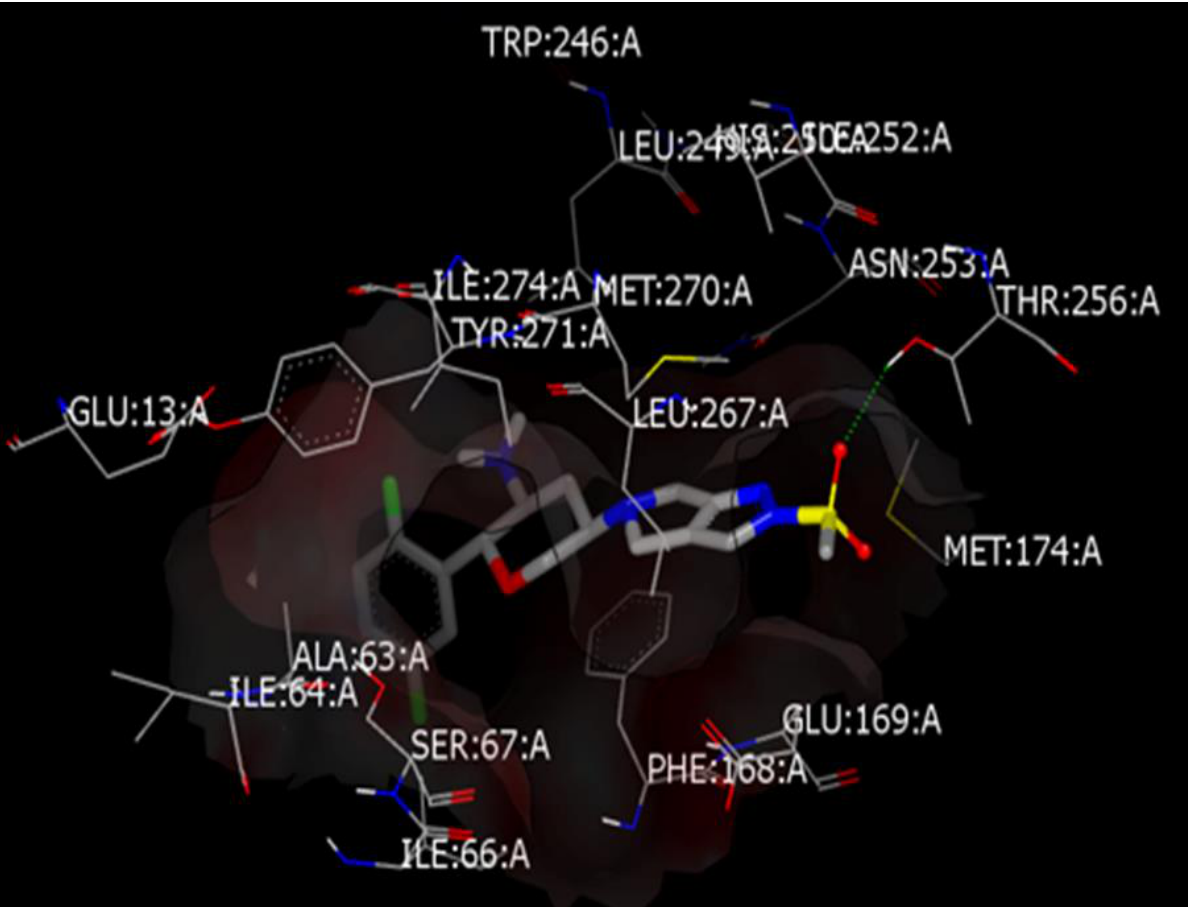
Figure 2. Predicted binding mode of OMR with A2AAR crystal structure.